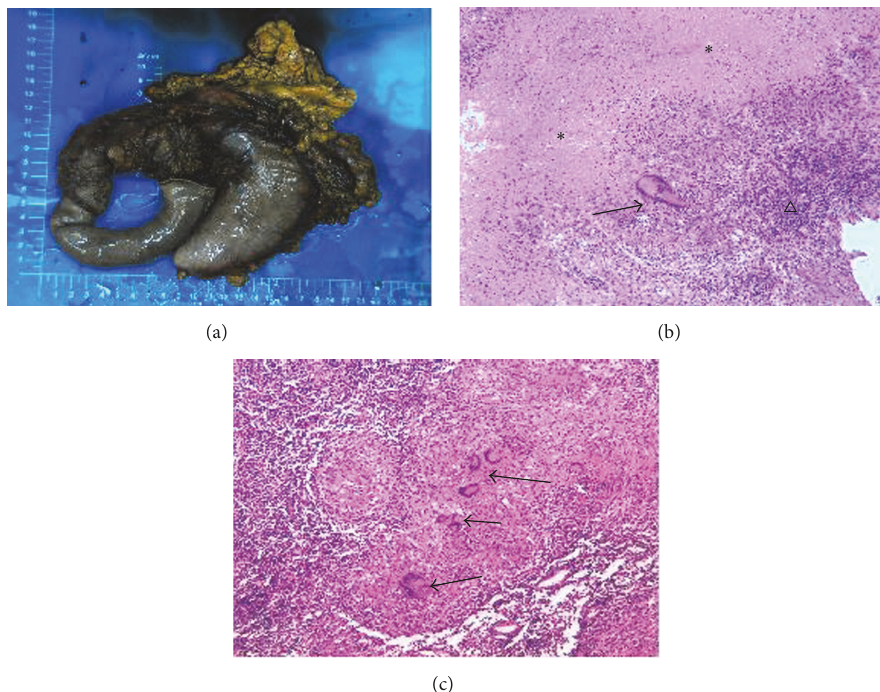
Figure 4: The histopathological pictures. (a) Whipple surgical specimens contained the pancreas, duodenum, partial stomach, and the omentum. The lesion was located on the pancreatic head. ((b) and (c)) HE staining. Granulomatous nodules consisting of lymphocytes, epithelioid cells, and multinucleated giant cells can be seen at the site of the lesion. Necrosis can be seen in the middle of nodules which were marked with an asterisk. The triangle marked the lymphocytes around the nodules. The arrow indicated the multinucleated giant cells reaction. These pathological features suggested tuberculous